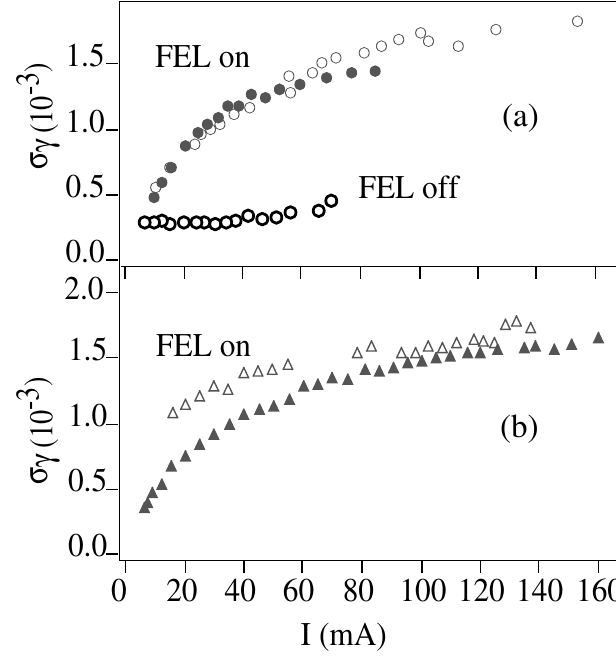
FIG. 7. Energy spread in the presence of FEL for different losses values, deduced from the transverse size measurements. (a) Achromatic optics: ( (cid:2) ) P (cid:6) 0 : 3% , ( (cid:12) ) P (cid:6) 0 : 12% . (b) Chromatic optics case: ( (cid:3) ) P (cid:6) 0 : 3% , ( 4 ) P (cid:6) 0 : 12% .